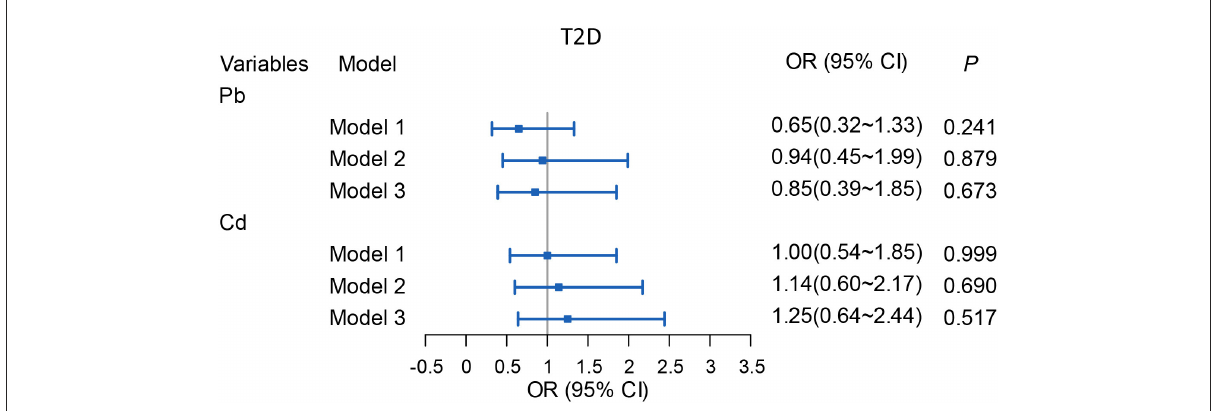
FIGURE4 Associations of ADDs [ µ g/(kg · d)] of Pb/Cd with T2DM among the total subjects. Model 1: The adjusted values for per capita monthly income, sex, age, education level and marital status, family history of T2DM. Model 2: The adjusted values for smoking, drinking, hypertension, weekly